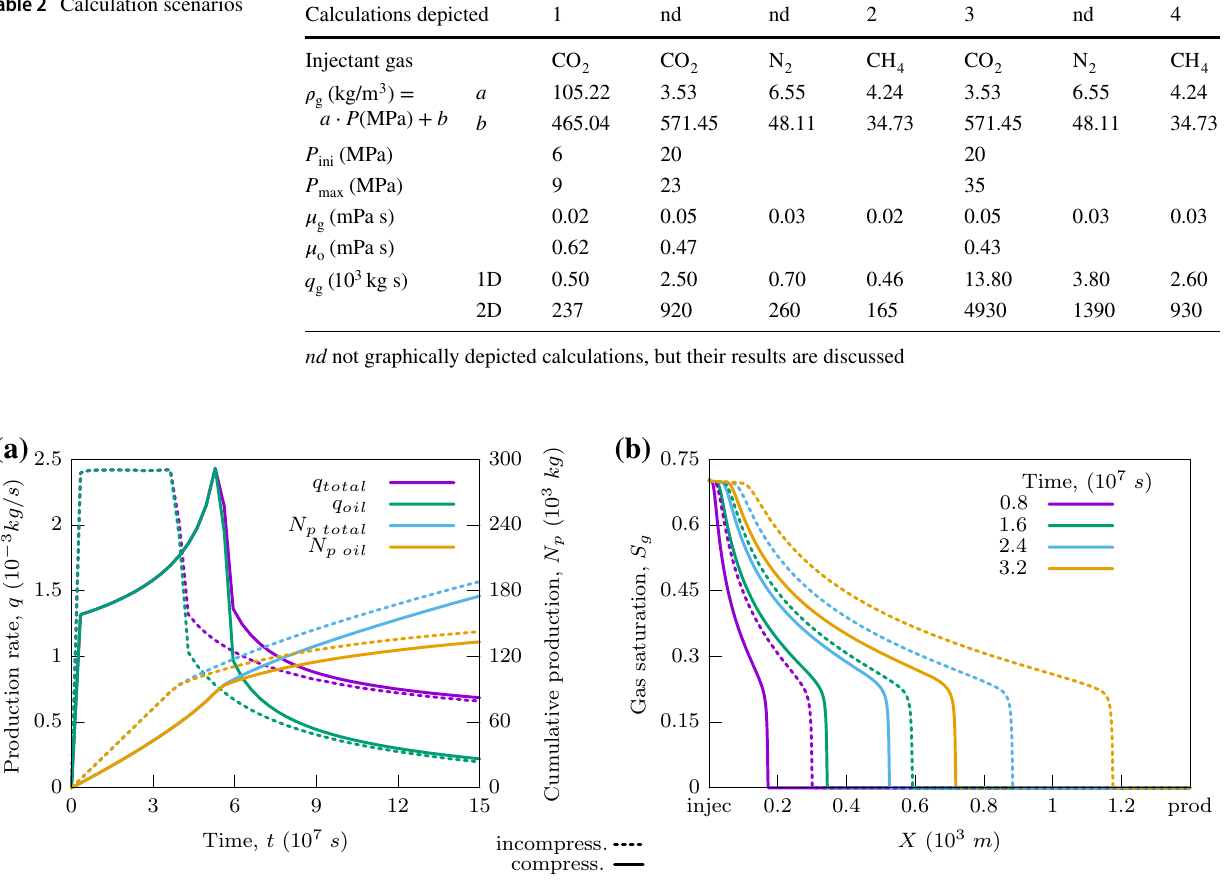
Fig. 3 Injectant gas CO 2 . 1D model. Scenario 1. Comparison of compressible and incompressible cases. a Production profiles. b Saturation pro-